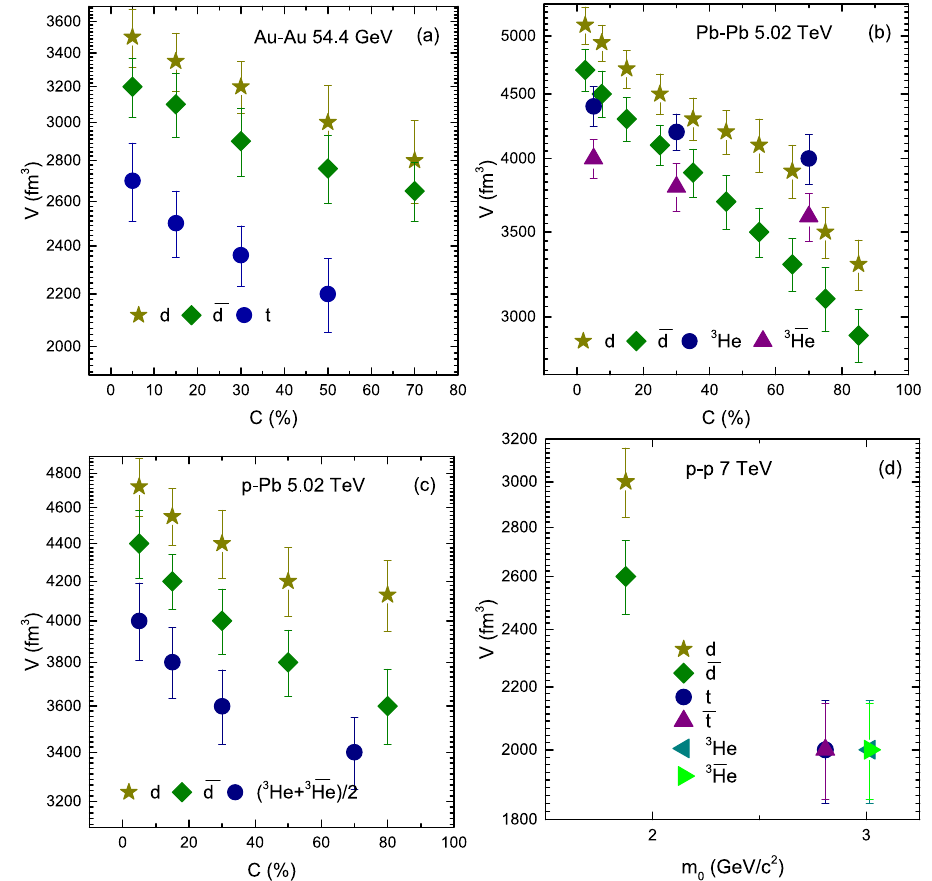
¯ 3 He ¯ d , t , ¯ t , 3 He and or